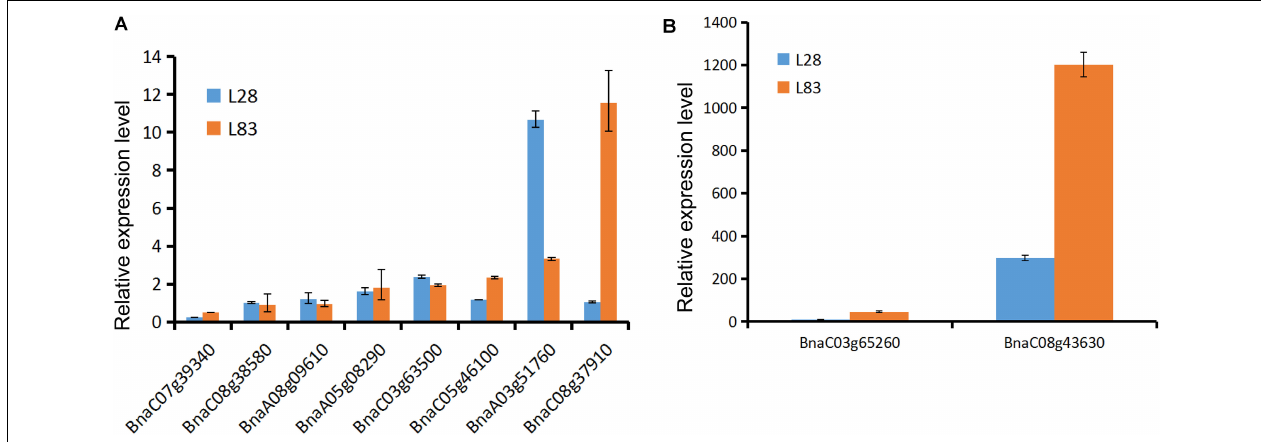
FIGURE 6 | The genes expression level in two lines after exposure to Cd based on qRT-PCR. The y -axis represents Cd-induced expression fold change relative to control treatment. (A) The genes expression level less than 15 times in both lines. (B) The genes expression level more than 15 times in one or both